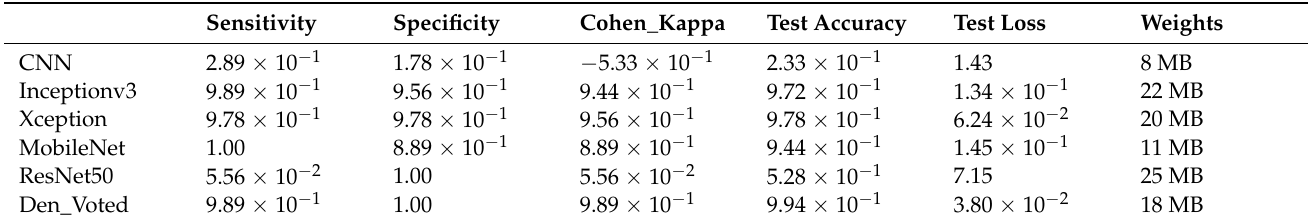
Table 3. Results achieved from the various learners with the industrial PCB